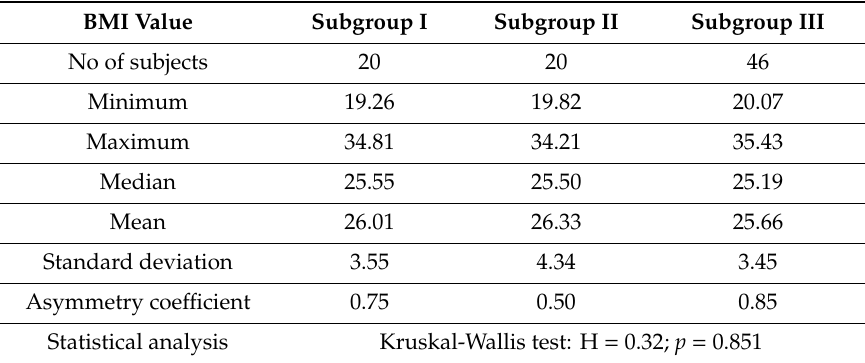
Table 3. Analysis of BMI values in the study population at the screening visit.